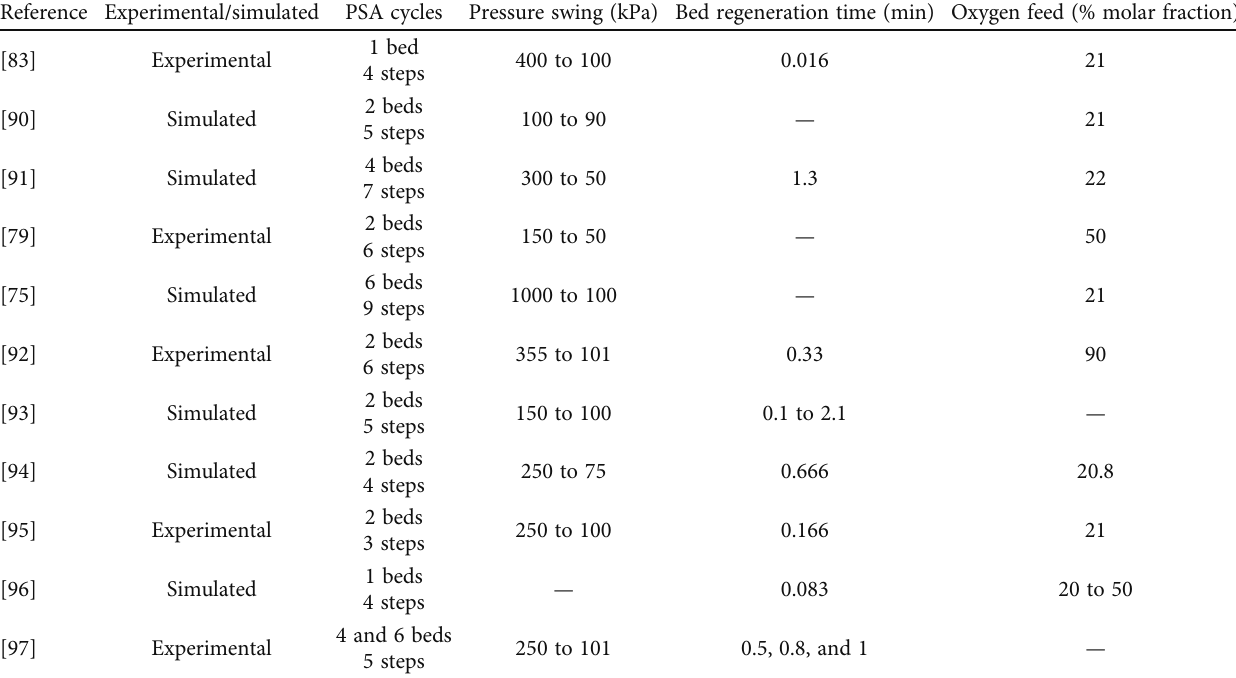
Table 15: Works reported on the di ff erent con fi gurations of PSA processes for puri fi cation of medical oxygen. Reference